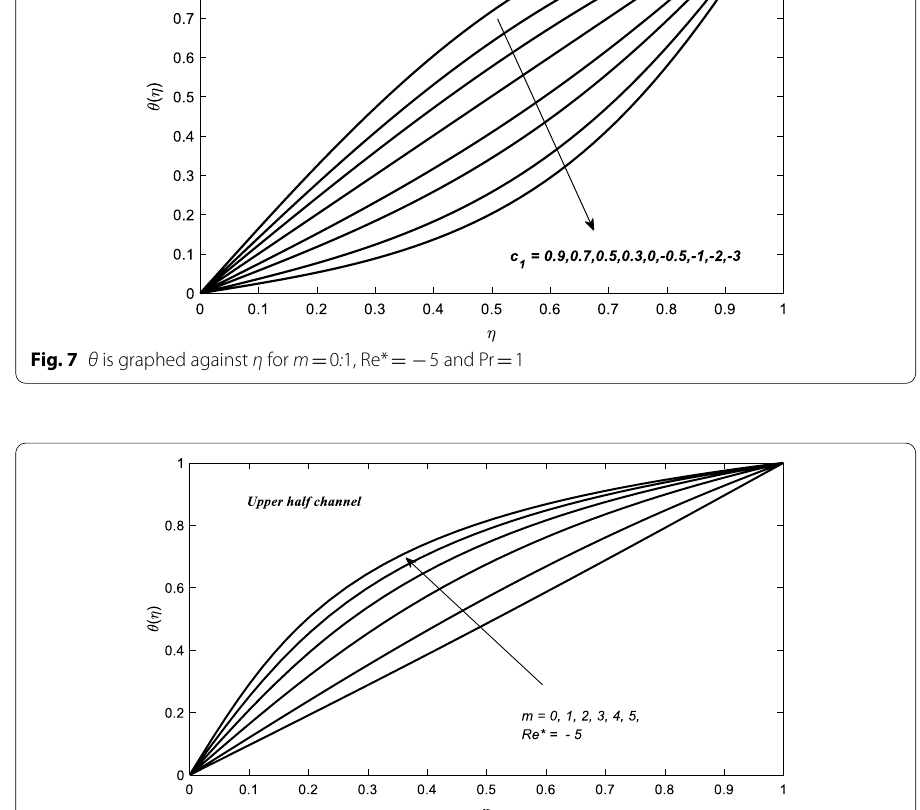
Fig. 8 Converging channel: The dimensionless temperature distribution ( θ ) in the upper channel is graphed against η for c 1 0.1 and Pr = =